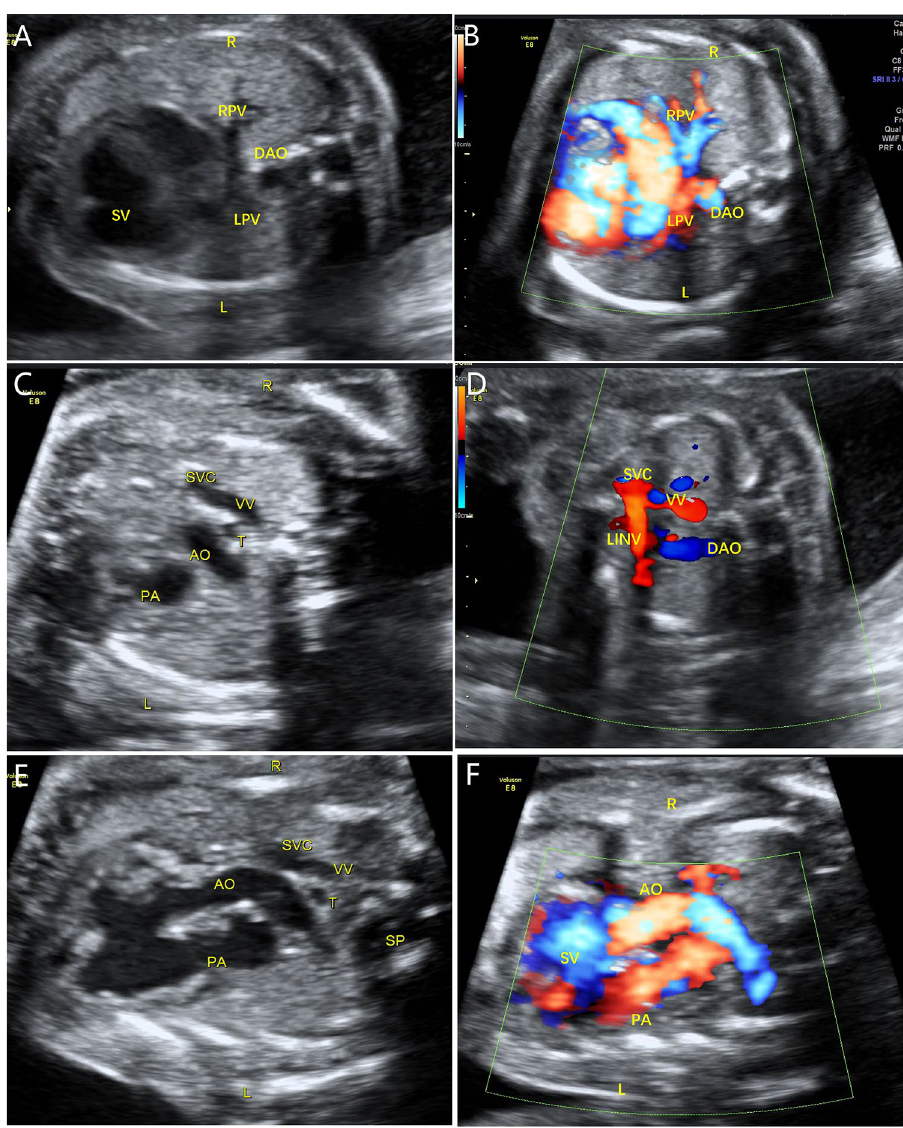
Figure 5. Prenatal ultrasound diagnosis of fetal supracardiac TAPVC with complex malformations. ( A , B ) Two-dimensional and color Doppler flow imaging showed the left and right PVs converging to form a common PV trunk, with an increased posterior left atrium index. ( C , D ) The common PV trunk returned to the right superior vena cava via the vertical vein in the view showing 3 vessels and trachea. ( E , F ) Aorta and pulmonary artery originating from a single ventricle. LINV left innominate vein, SP spine, SVC superior vena cava, T trachea, VV vertical